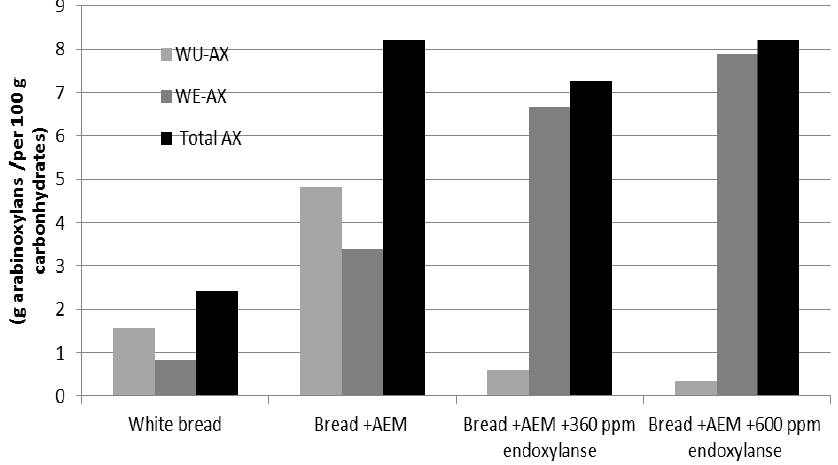
Figure 4. Water unextractable arabinoxylan (WU-AX), water extractable arabinoxylan (WE-AX) and total arabinoxylan content per 100 g of available carbohydrates in white bread, bread + AEM, bread + AEM with 360 ppm of endoxylanase and bread + AEM with 600 ppm of